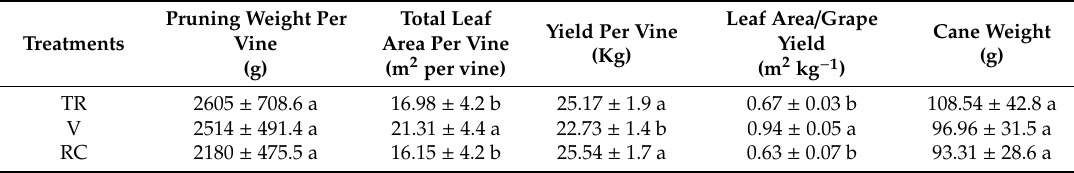
Table 3. Soil management e ff ects on the vegetative and vine e ffi ciency parameters in 2015–2016. (Values are means ±